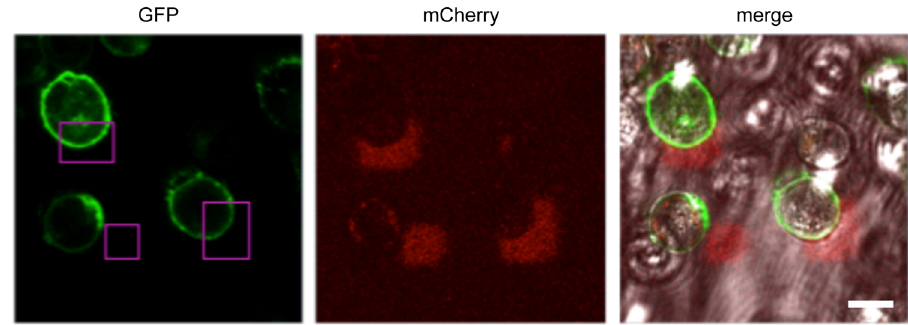
Fig. 6 Subcellular protein patterning of a cell-laden, photoinstructive hydrogel by 2P laser lithography. In close proximity to encapsulated HeLa cells stably expressing Y2R mEGFP , distinct ROIs (magenta boxes) were simultaneously photoactivated at 800 nm (3.1 mW, 18 s) and subsequently assembled with His 6 -mCherry (300 nM). Within the user-speci fi ed gel subvolumes, the 2P-activation of TPA- tris NTA created anchoring sites for the His 6 -POI in the photoinstructive hydrogel, demonstrating successful 2P-scisision of TPA- tris NTA in presence of and close proximity to living cells. Scale bar: 10 µ